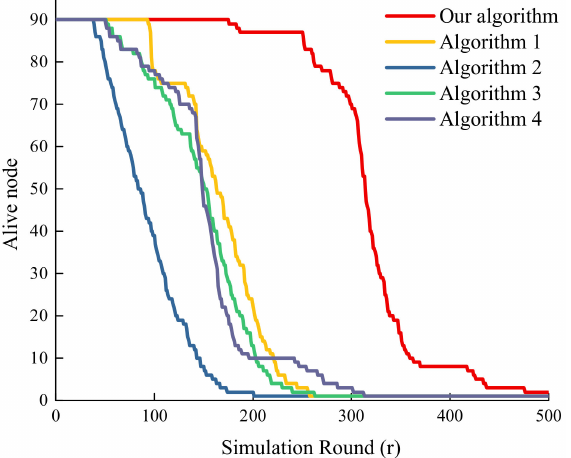
Figure 2. The number of failed